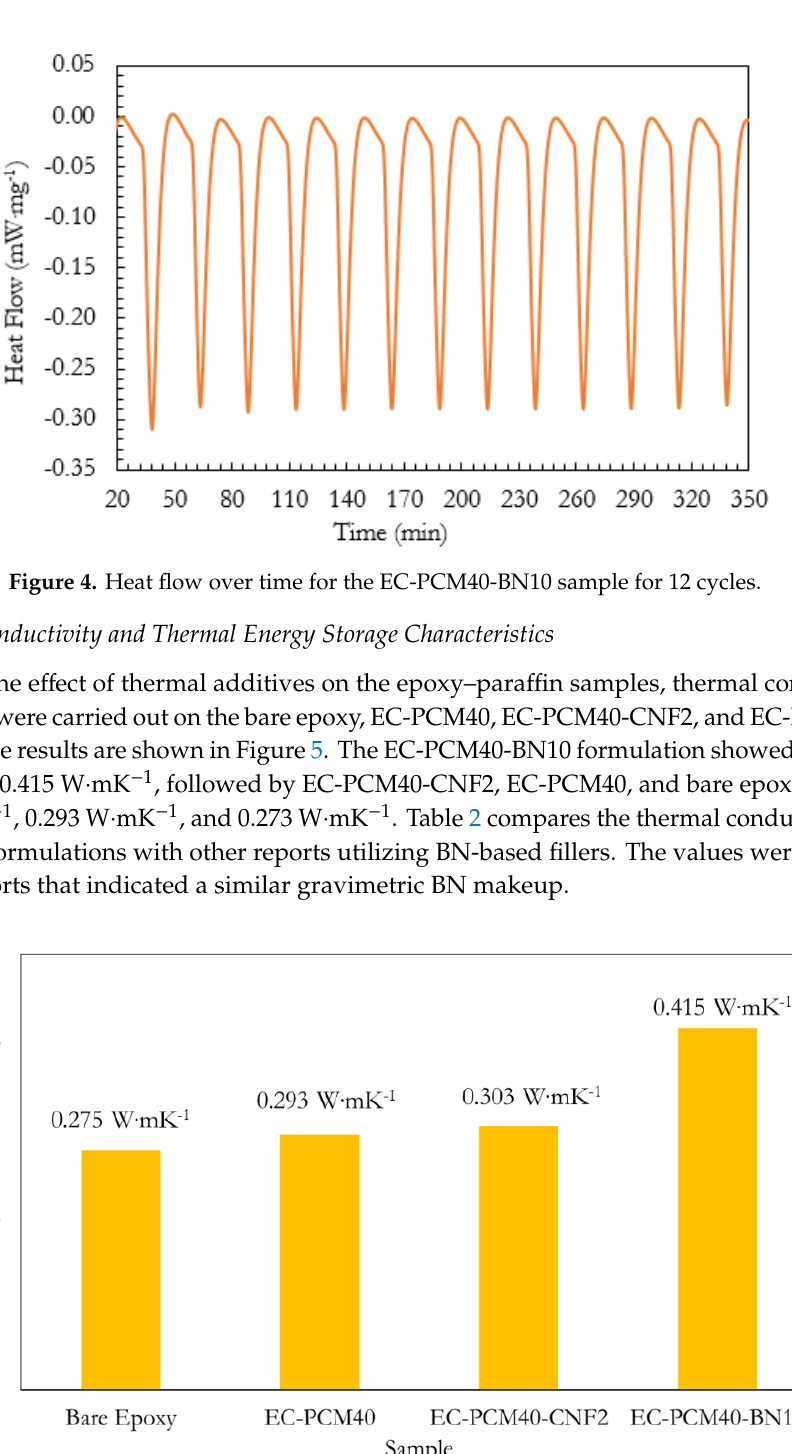
Figure 3 . Heating curves of the a ) epoxy–PCM formulations incorporated with carbon nanofillers and